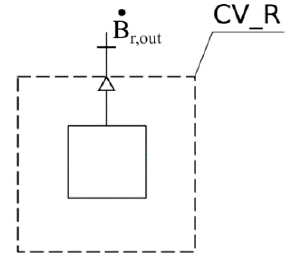
Figure 2. Exergy model for a reservoir.